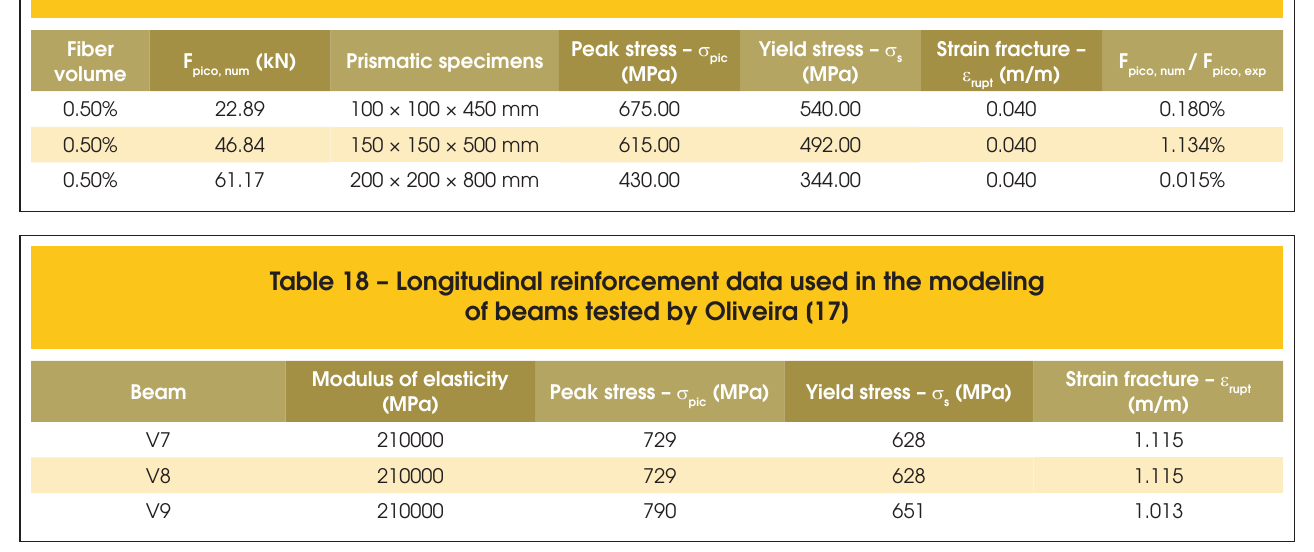
Table 17 – La Borderie [4] parameters for the calibrated curve of the concrete beam V7 with 0.5% fibers